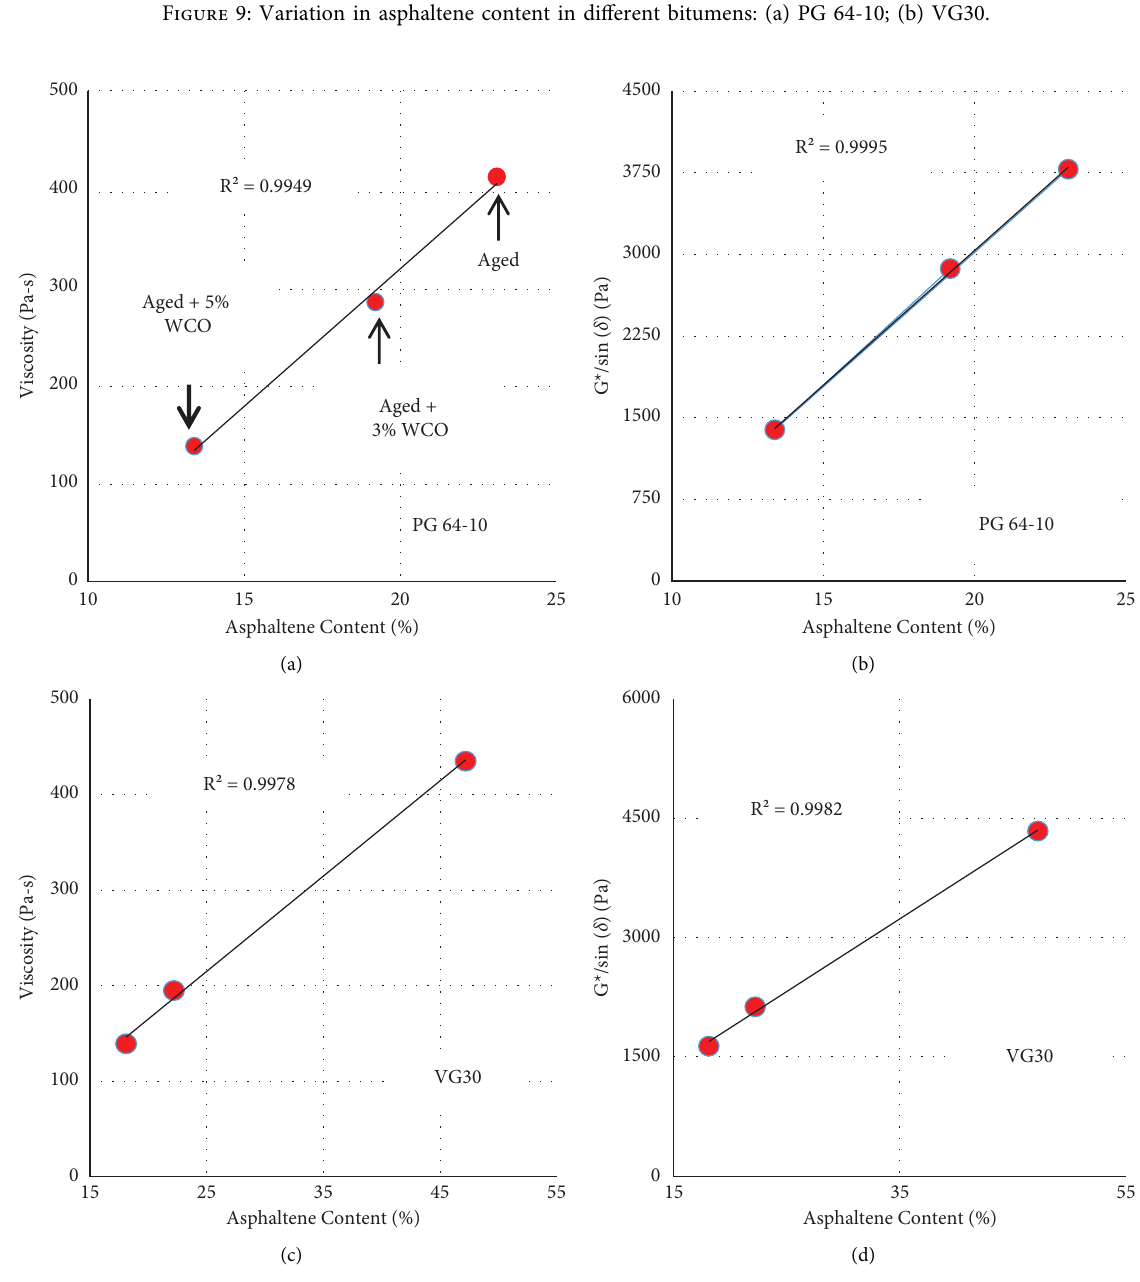
Figure 10: Relationship between asphaltene content and rheological properties determined at 64 ° C and 1.59Hz